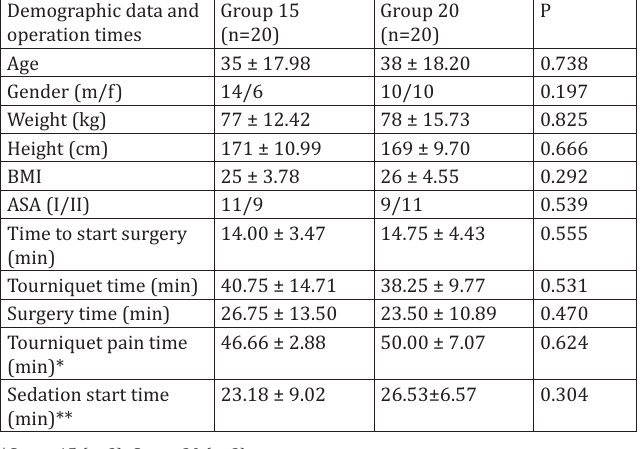
Demographic data and operation times